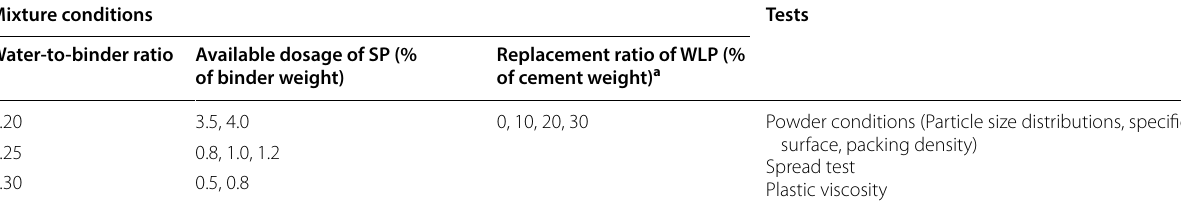
a The replaced powder was prepared with three different levels of fineness.